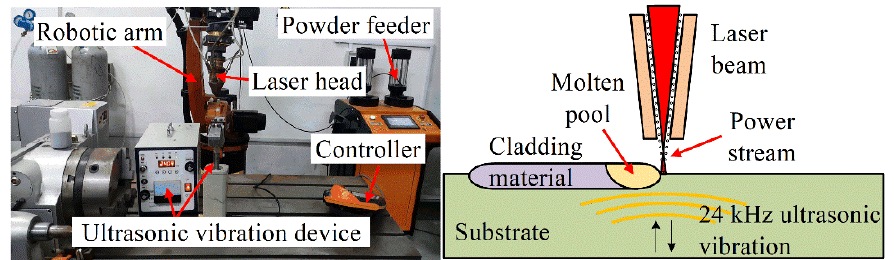
Figure 2. Experimental device and schematic diagram of laser cladding assisted by ultrasonic vibra- tion.